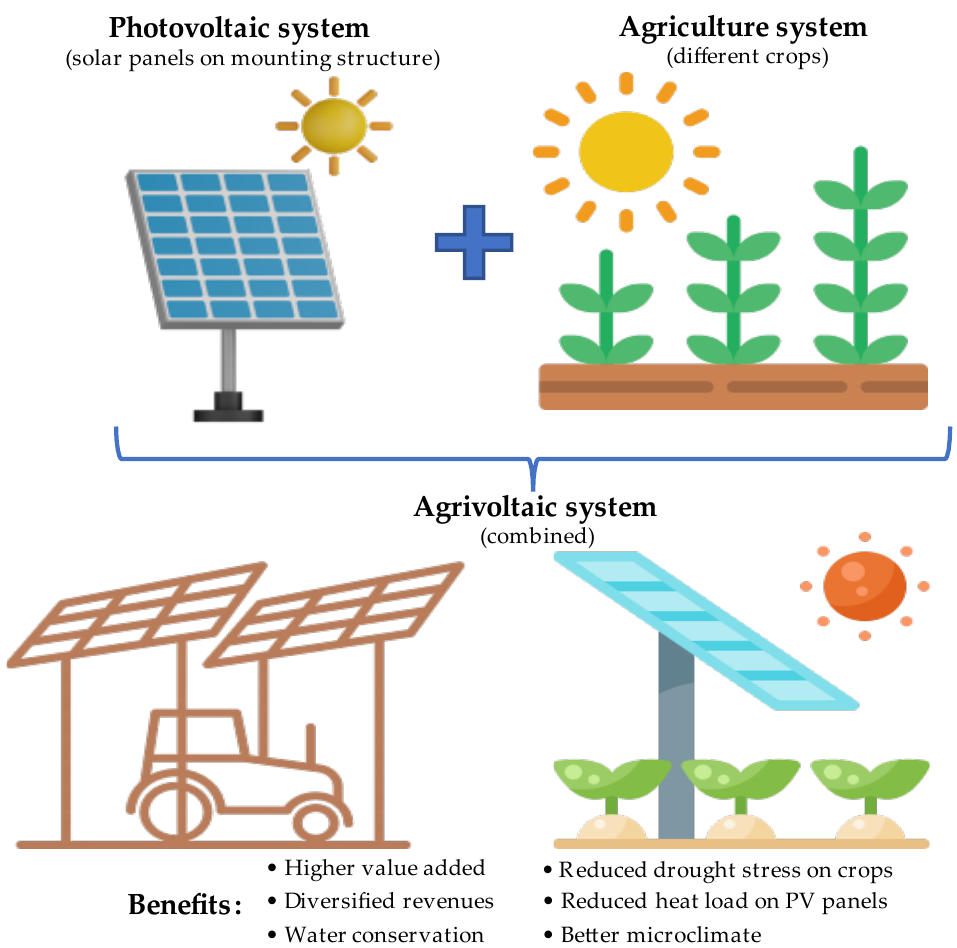
Figure 1. Comparison diagram of Agrivoltaic system and PV systems on the same agricultural land. Source: created by the authors.